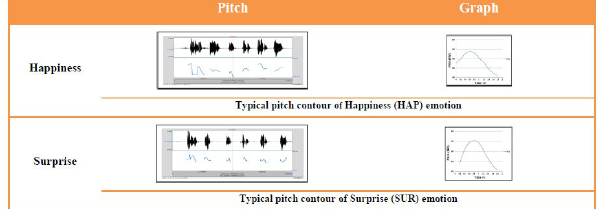
Fig. 5. American pitch contours for Happiness and Surprise.